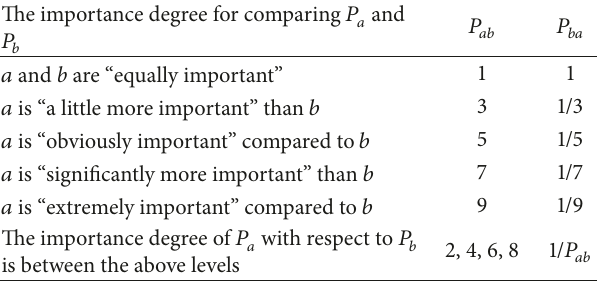
Table 3: The judgment values for determining the importance degree between the criteria 𝑃 𝑎 and 𝑃 𝑏 .